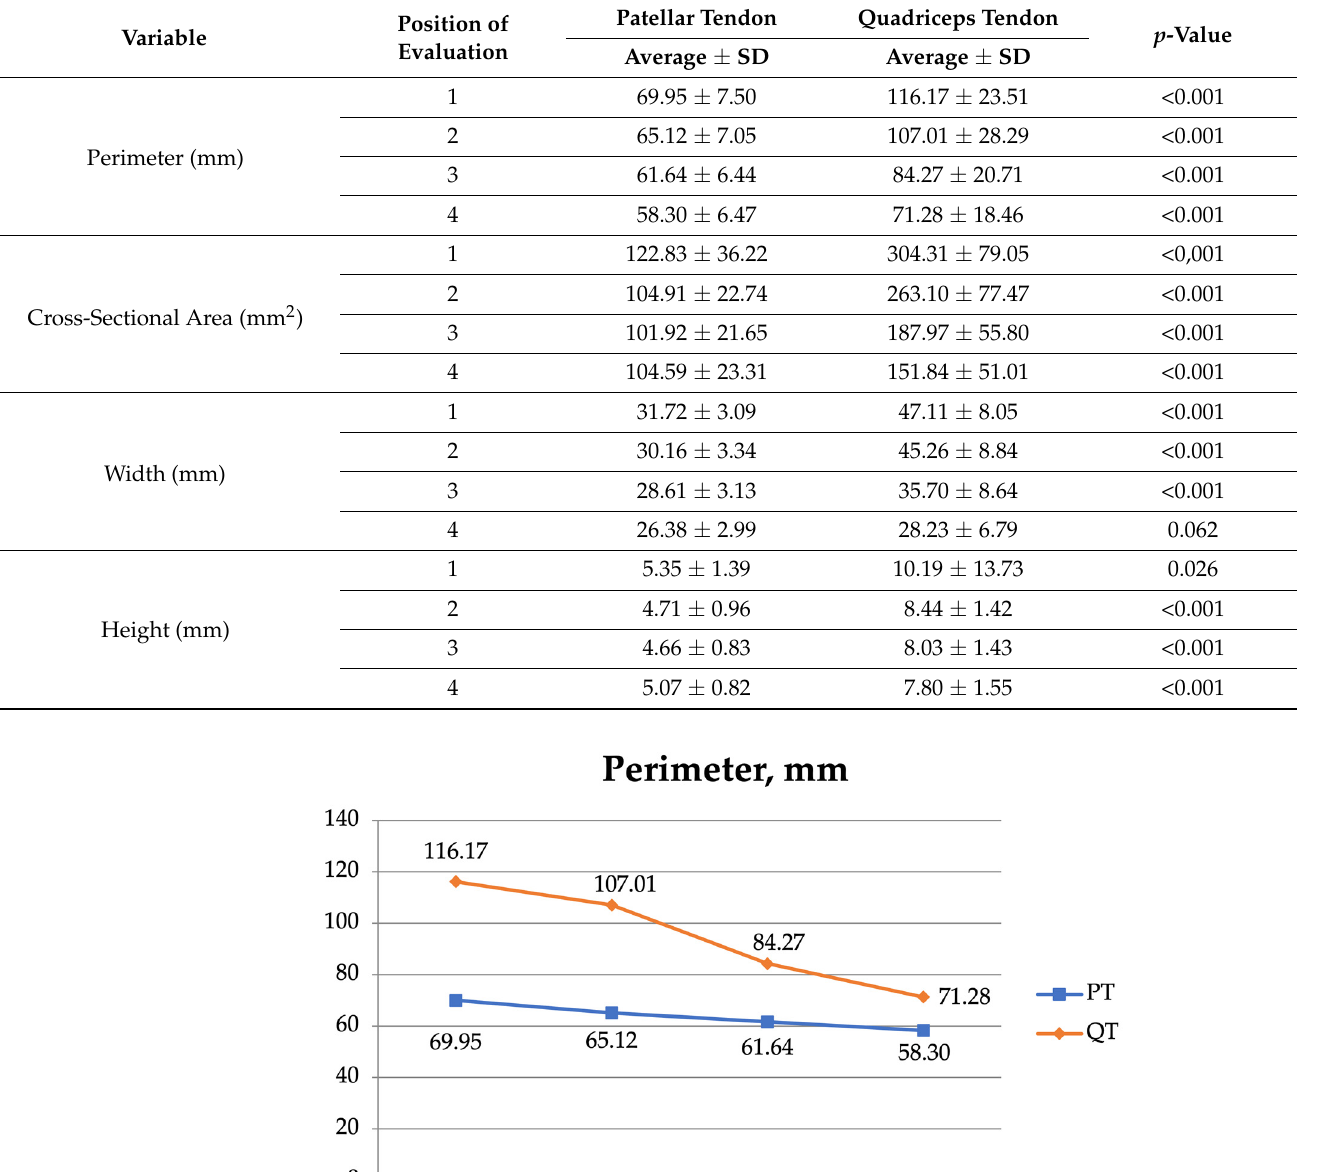
Table 5. Comparison between the patellar and the quadriceps tendons’ dimensions at four different measurement sites distal and proximal to the distal and the proximal patellar pole, accordingly. CSA, cross-sectional area; SD, standard deviation.